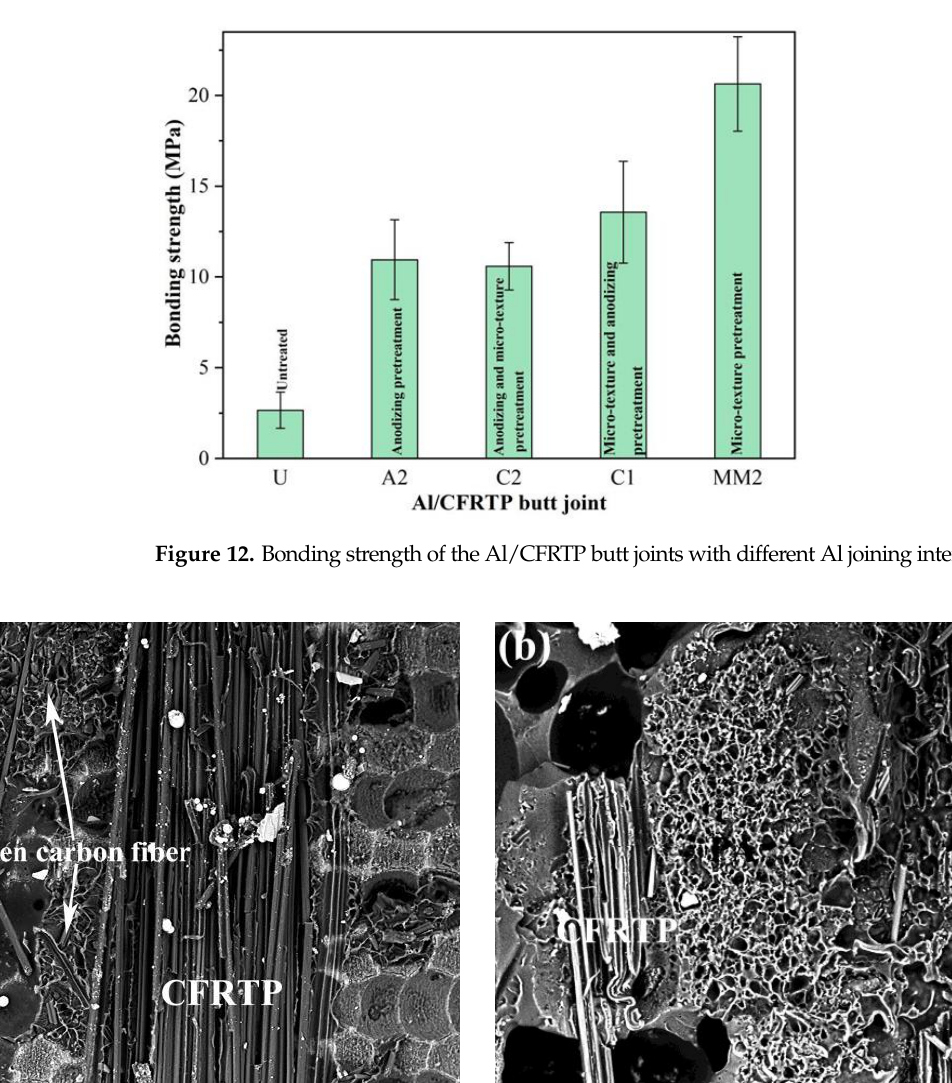
14 of 19 Figure 11. Surface morphology of the Al alloy joining interface pretreated by anodizing of 10 min and subsequent laser micro-texturing ( a ) and laser micro-texturing and subsequent anodizing of 10 min ( b ) (inset image showing the 3D morphology analyzed by LSCM with magnification of 400 × ). The bonding strength of the Al/CFRTP butt joints with Al joining interface pretreated by hybrid pretreatments, untreated, typical anodizing, and micro-texturing are summa-